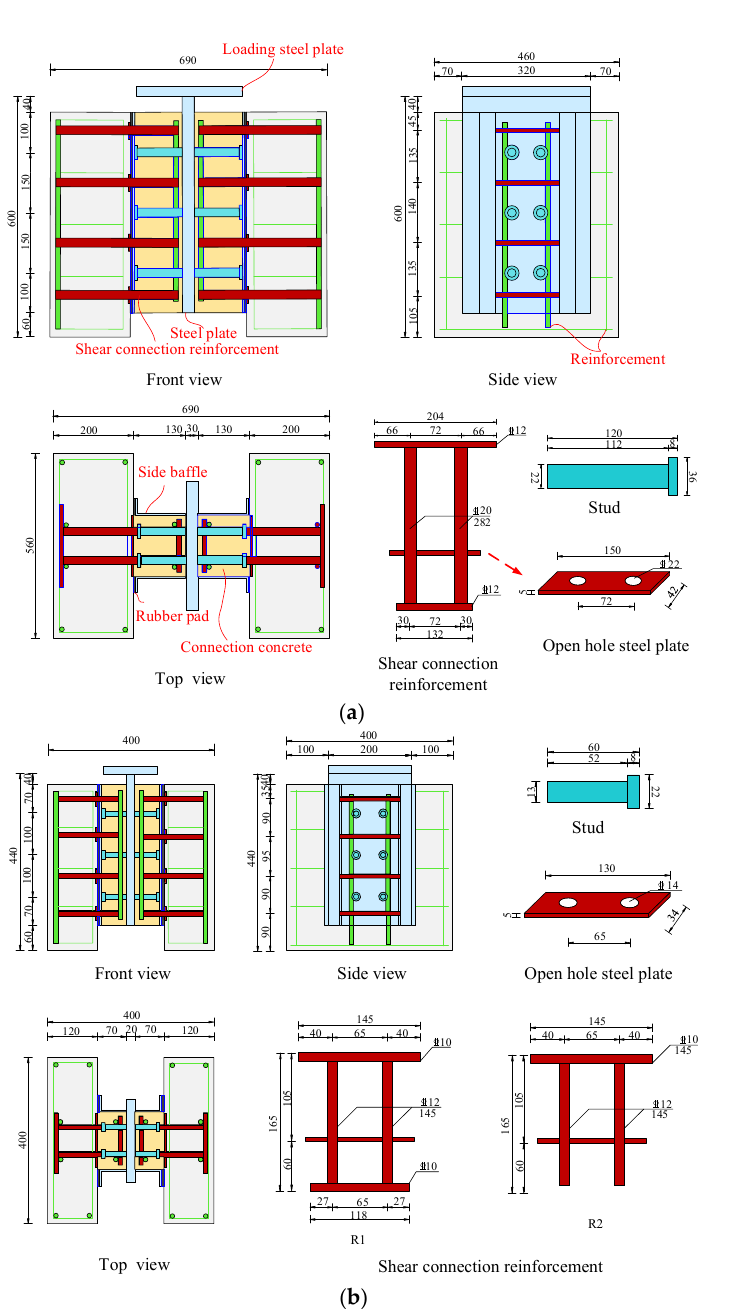
Figure 1. Details of push-out specimens: ( a ) SCM1-120 soecimen; ( b ) Specimen with 13 mm diameter stud. (Unit: mm). Table 1. Summary of experiments details and parameters. Table 2. Mix ratio of precast